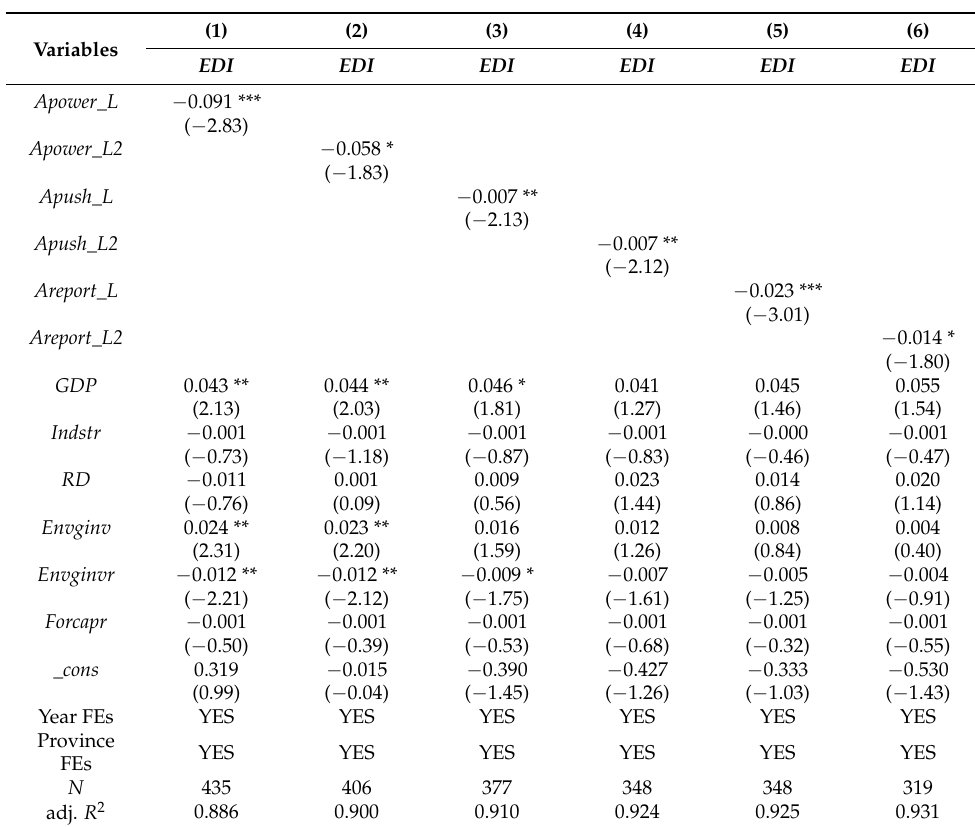
Table 10. Lagging effect of government environmental